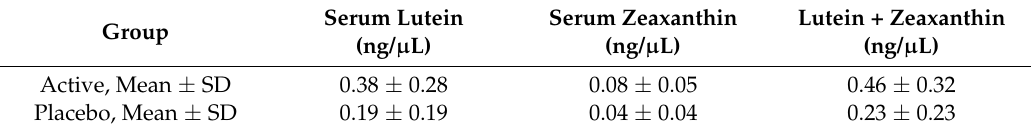
Table 4. Serum levels following one year of supplementation.